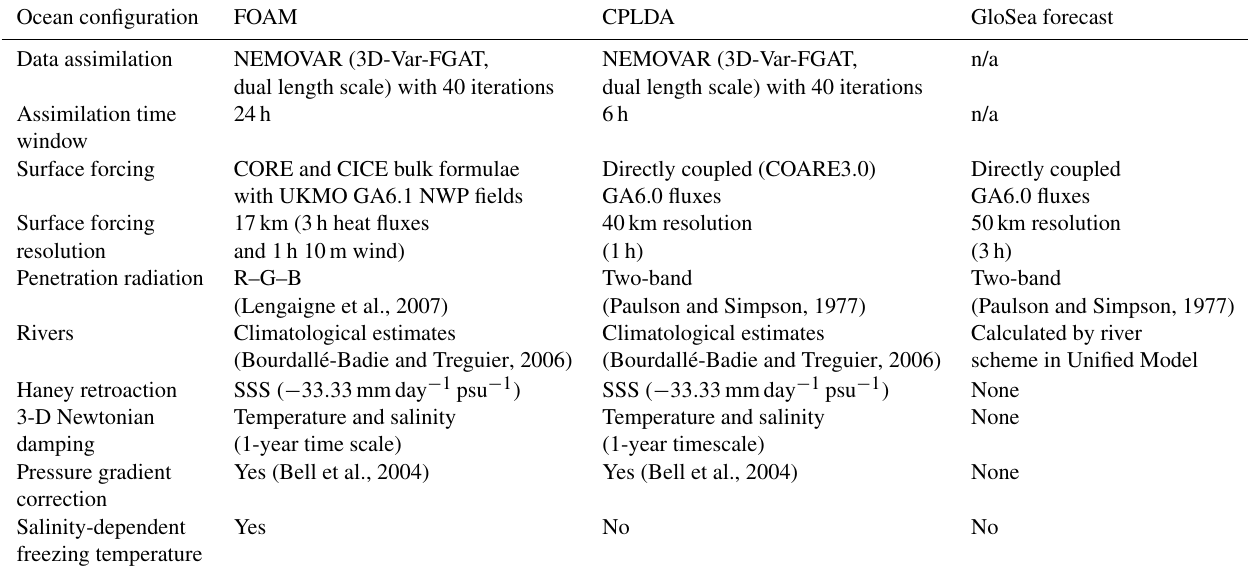
Table 1. The FOAM , CPLDA and GloSea ocean configurations. Ocean